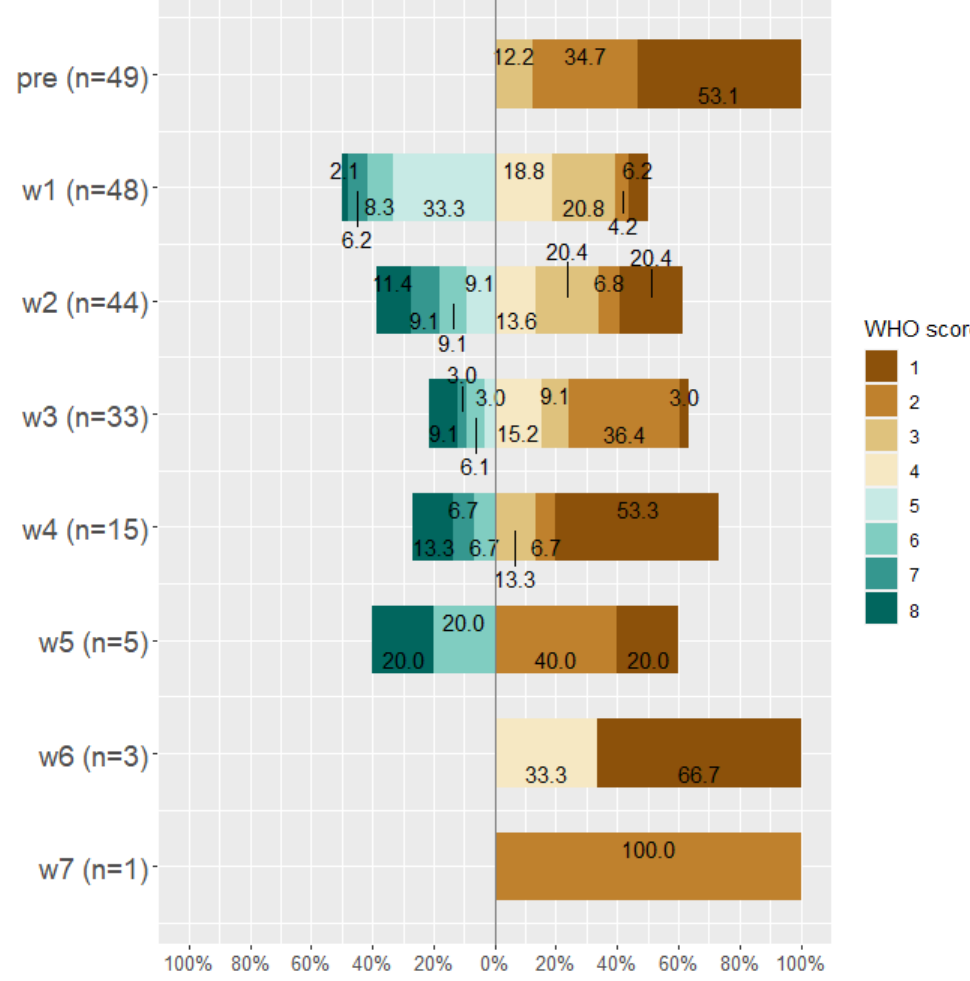
Figure 3. WHO score for all patients ( n = 49) before taking Tocilizumab and at weeks 1, 2, 3, 4, 5, 6, and 7 after Tocilizumab administration.